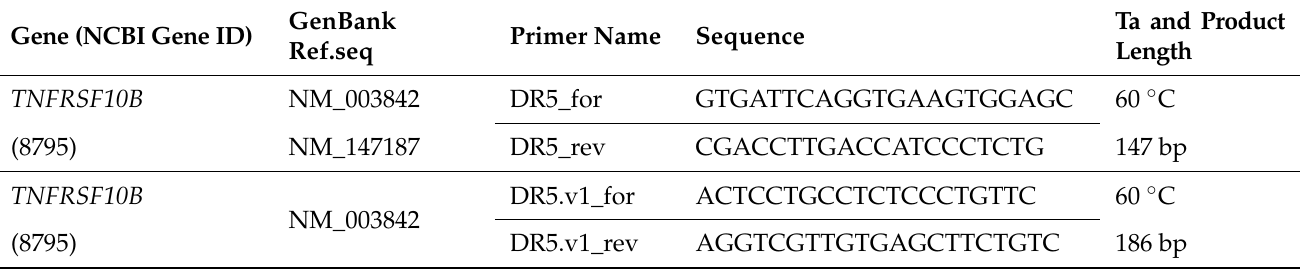
Table 5. Sequences of used RT-qPCR primers. Annealing Temperatures (Ta) and Product Lenghts are in table. Gene (NCBI Gene